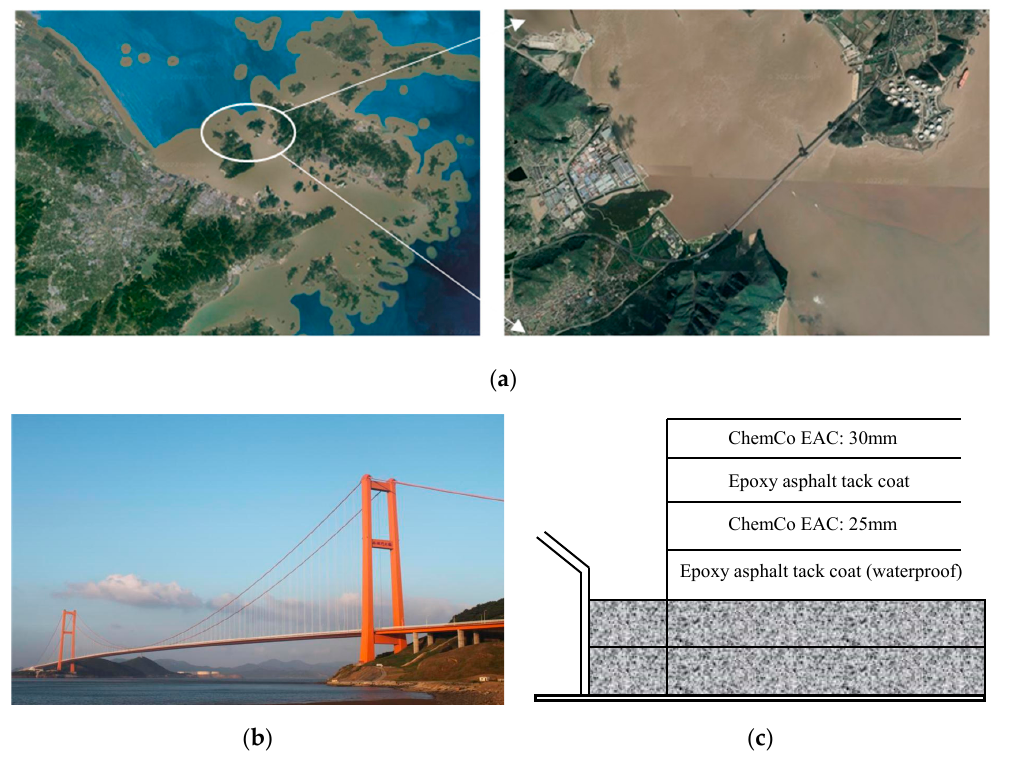
Figure 2. Location and appearance of XHMB : ( a ) geographical location diagram; ( b ) external view; ( c ) pavement structure. Table 1. Main parameters of XHMB.